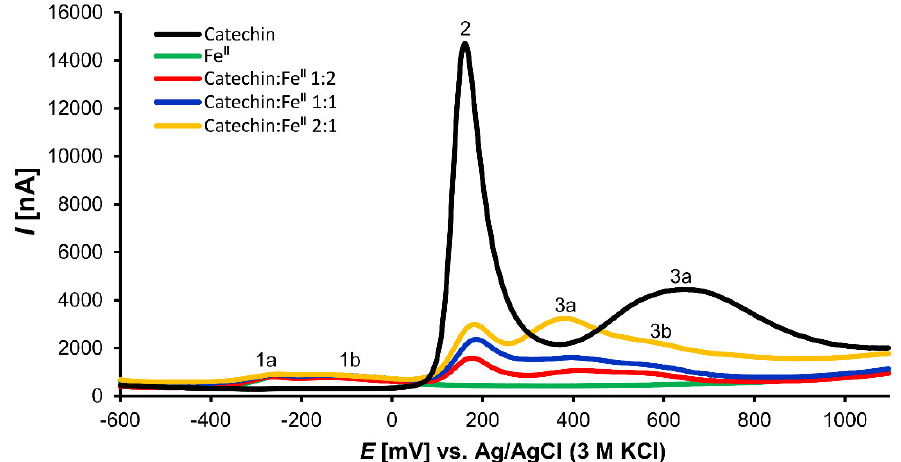
Figure 4. Differential pulse voltammogram of 1 mM solutions of Fe II and Fe III in phosphate buffer (pH 7.4).